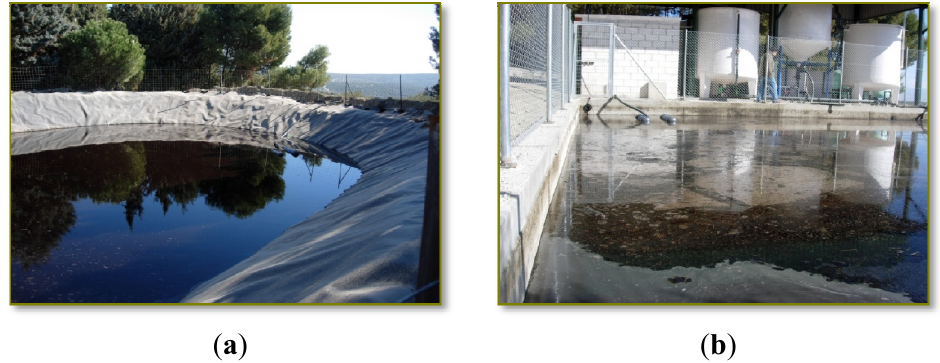
Figure 1. Olives washing wastewater (OWW) ( a ) and olive oil washing wastewater (OOW) ( b ) storage and evaporation